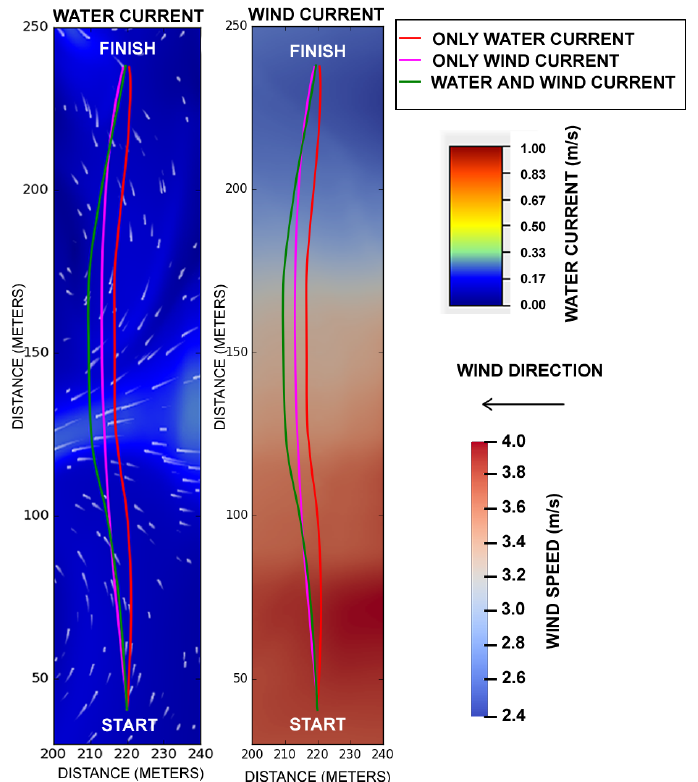
Figure 11. Differential boat travelling on straight line. The red line presents the trajectory of the boat when it is affected only by the water current. The pink trajectory, when the differential boat is affected only by the wind current. The green trajectory when the boat is affected simultaneously by wind and water